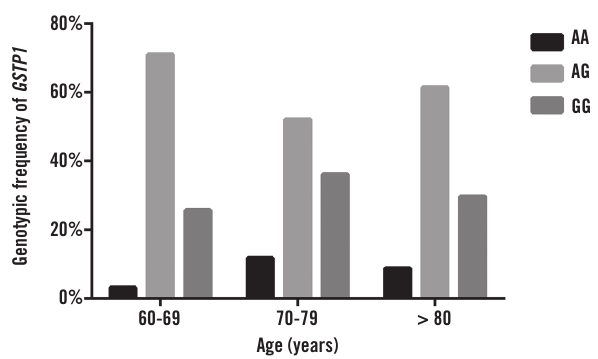
FigurE 3 − Genotype distribution of GSTP1 polymorphism in relation to age. Chi-square test p = 0.2939 GSTP1 : glutathione S-transferase